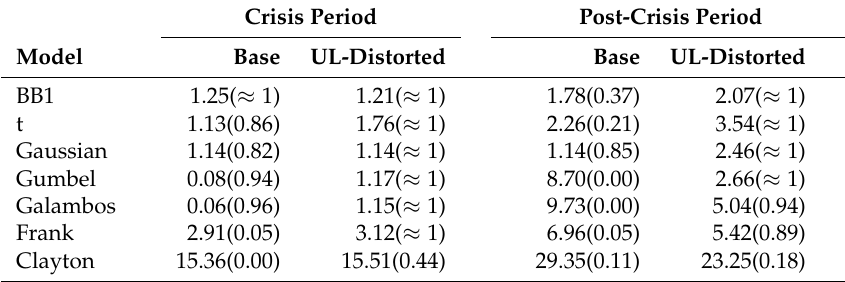
Table 5. Cramer-von Mises test statistics in hundredths and p -values in parentheses for copulas in Tables 3 and